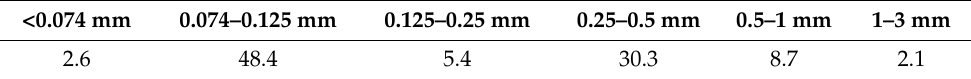
Table 1. Chemical compositions of fluorine-bearing iron concentrate, bentonite and specularite/wt.%. Kind TFe FeO FIC Specularite The mass fraction of fluorine-bearing iron concentrate and bentonite size of less than 0.074 mm account for 85.2% and 26.8%, respectively [14]. The specific surface area of fluorine-bearing iron concentrate is 1683 cm 2 .g − 1 [14]. Table 2 shows the particle distribution of specularite. Specularite has a relatively thick grain size, less than 0.074 mm, which only accounts for 2.6%. Its specific surface area is only 865 cm 2 .g − 1 . Table 2. Grain size distribution of